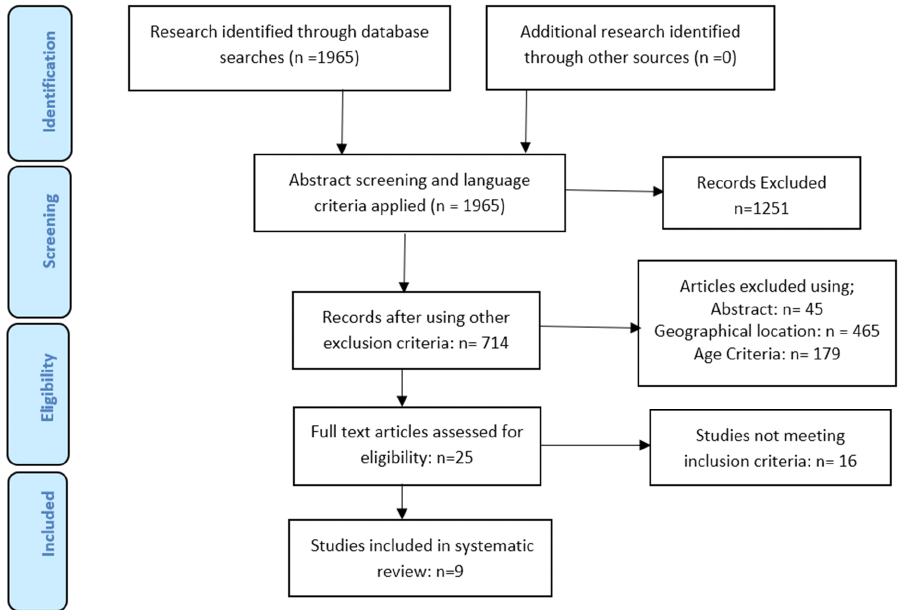
Figure 1. PRISMA Flow Diagram on selection and inclusion of studies.